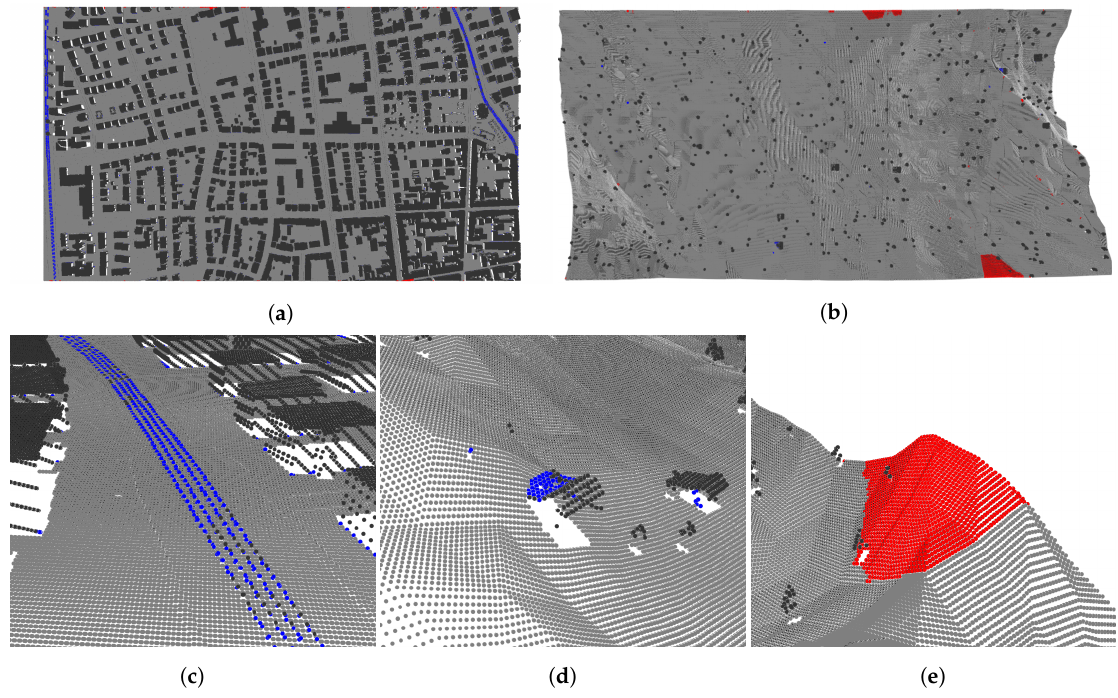
Figure 8. Error distribution in the ( a ) urban and ( b ) rural synthetic data and ( c – e ) sources of error. Legend: type I error (red), type II error (blue), ground points (light grey), and non-ground points (dark